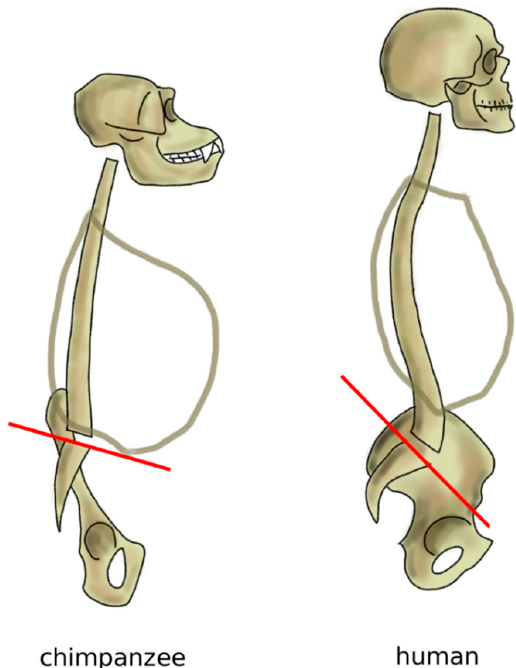
Figure 9. Sagittal profile of the spine in chimpanzees in standing posture and humans. Chimpanzees have an almost horizontal sacral plate, which forces the spine to assume a C-shape. In humans, the higher sacral slope determines the development of an S-shape.